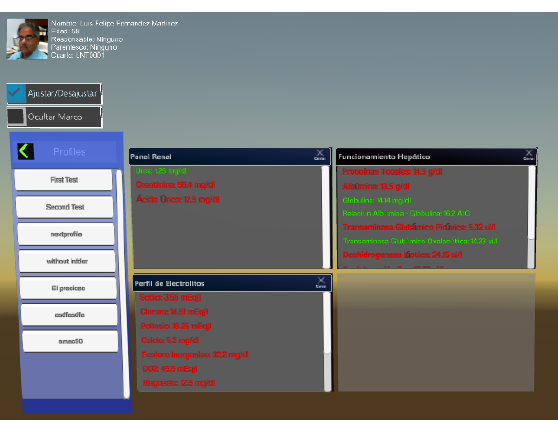
Figure 6. An initial interface in “Around Scene” and patient selection.